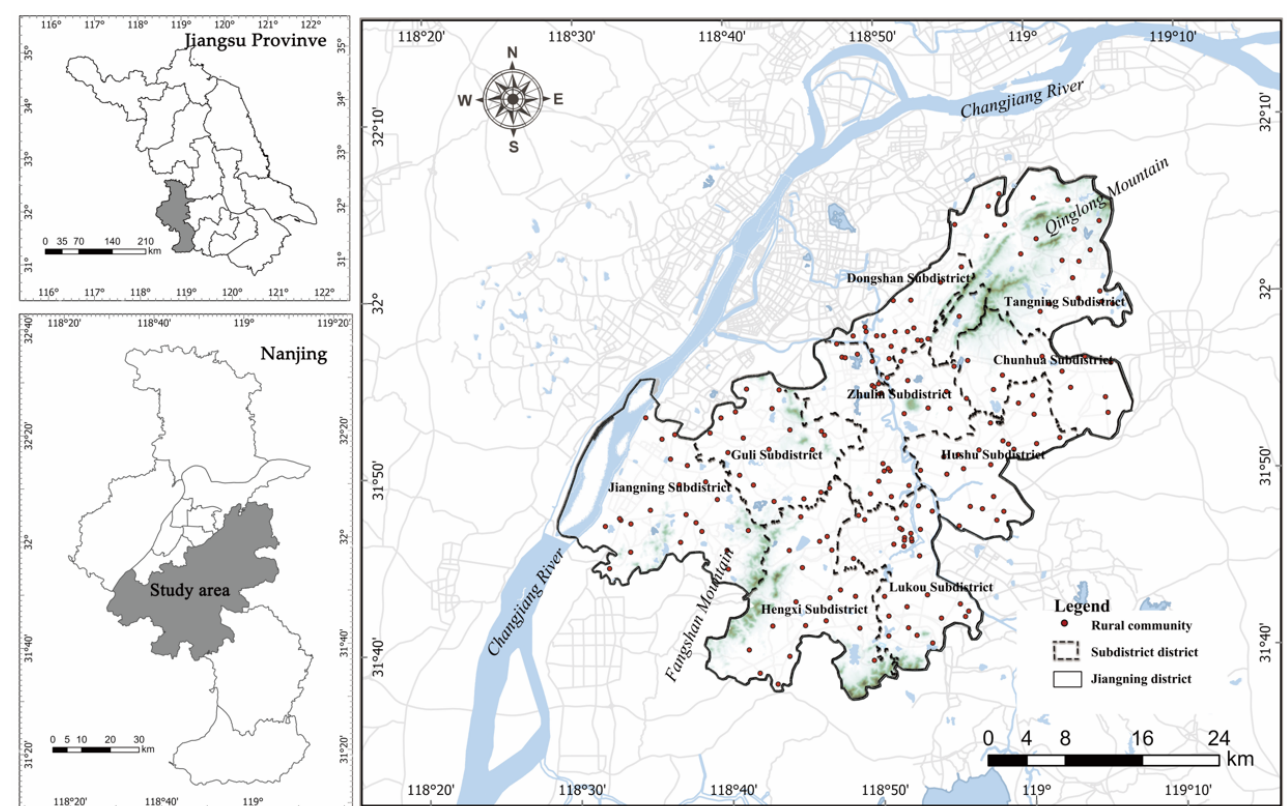
Figure 1. The location of the study area.